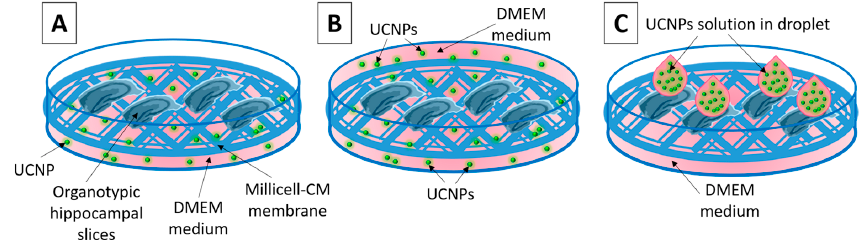
Figure 2. Diagram showing the three analyzed methods of applying UCNPs to the OHSC: ( A ) UCNPs are added to 1 mL of the culture medium under the membrane, ( B ) the OHSCs placed on the membrane are immersed in the culture medium containing UCNPs, ( C ) UCNPs solution in droplet applied to the slice surface.